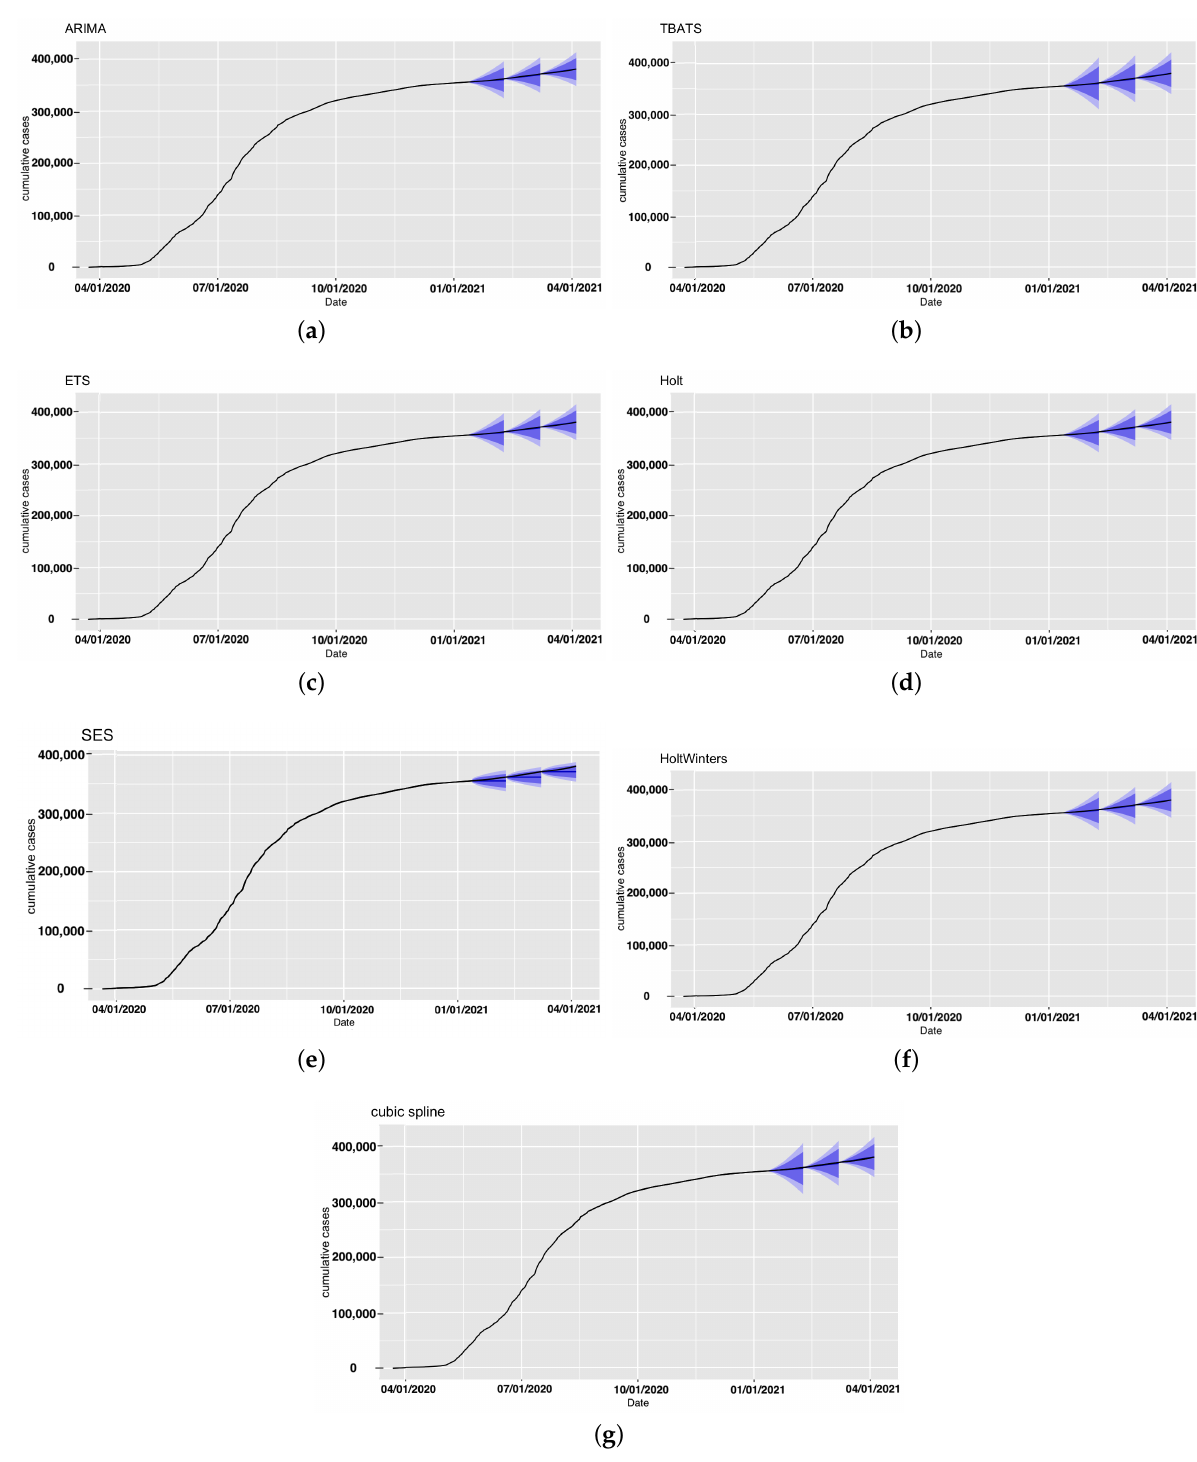
Figure 5. Forecast recoveries in Saudi Arabia for all models with the prediction intervals (in blue). ( a ) ARIMA, ( b ) TBATS, ( c ) ETS, ( d ) Holt, ( e ) SES, ( f ) HoltWinters, and ( g ) cubic